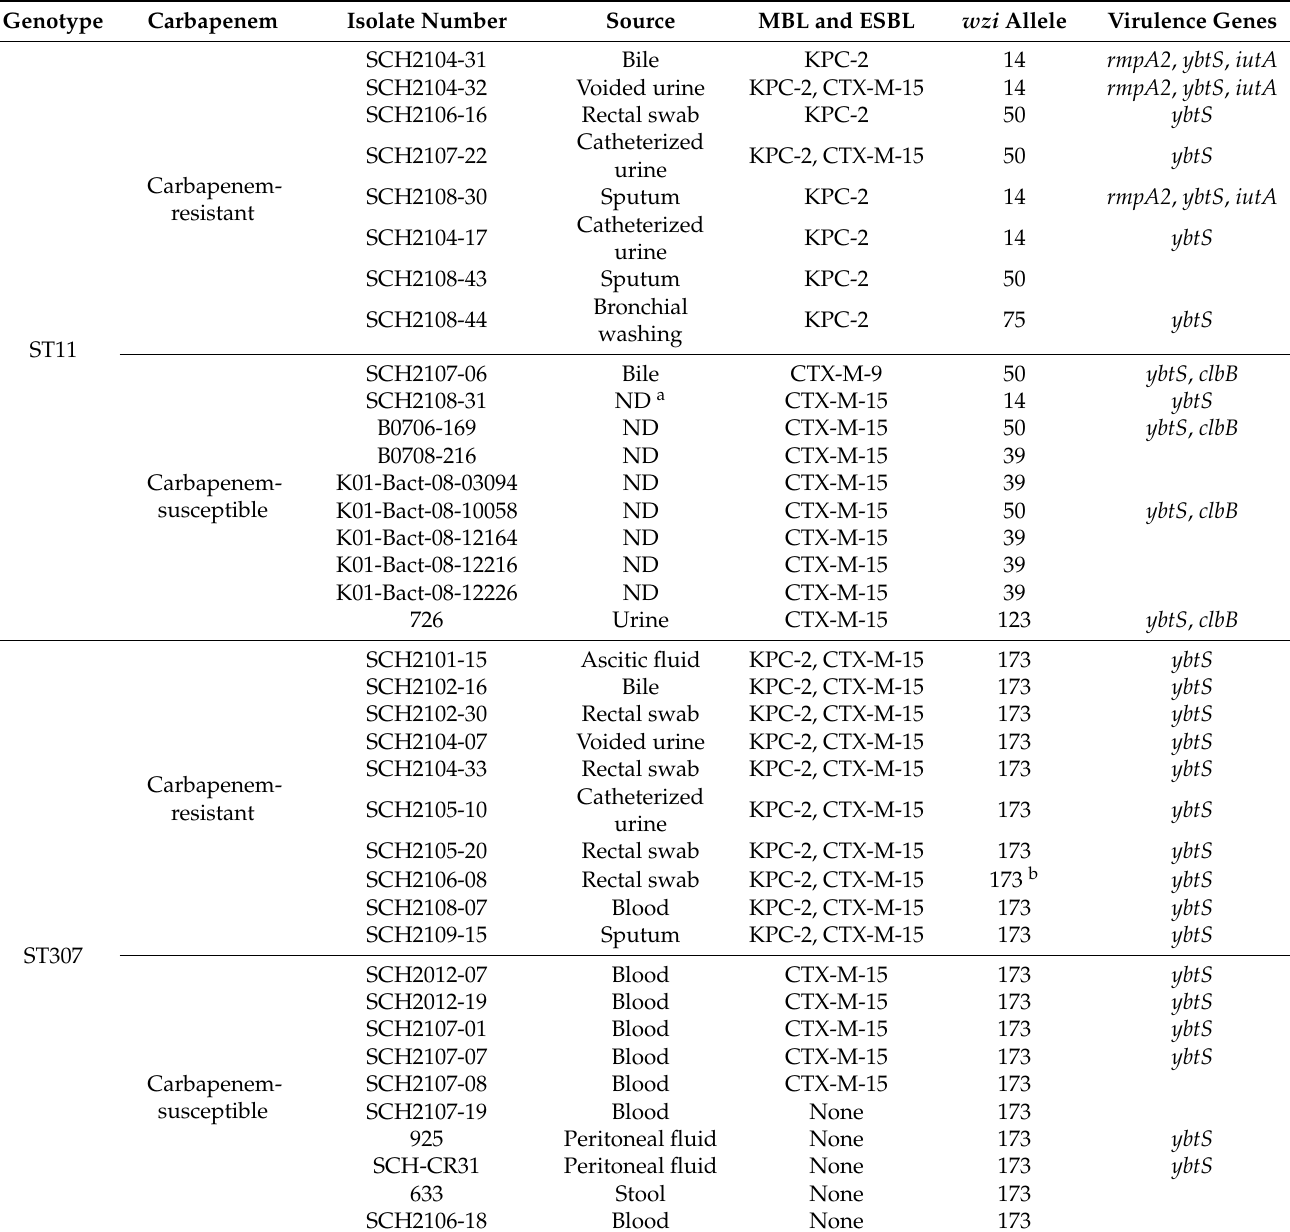
Table 1. Sources, wzi alleles, and virulence genes of two K. pneumoniae clones from South Korea, ST11 and